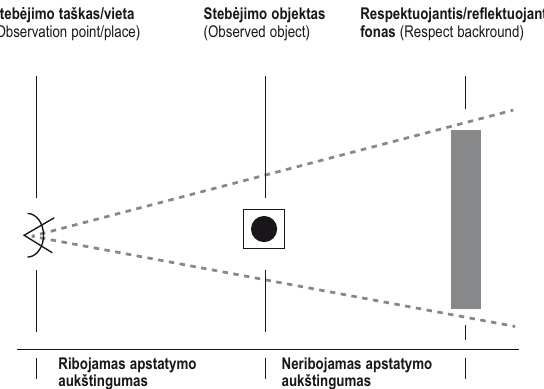
Fig 1. Elements of ekspositional (respect)